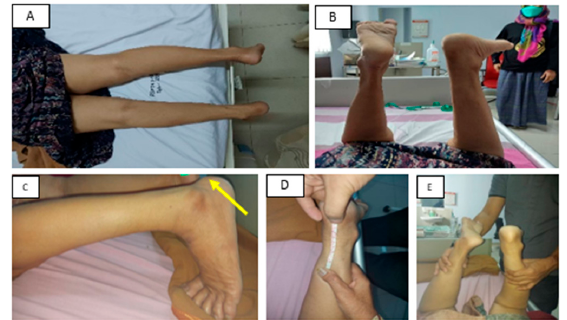
Figure 1. Preoperative clinical photo. ( A , B ) clinical picture of the patient’s legs; ( C ) Haglund’s deformity (arrow); ( D ) the measurement of the seven-centimeter gap between the insertion of the Achilles tendon and the calcaneus bone; ( E ) positive Thompson test.